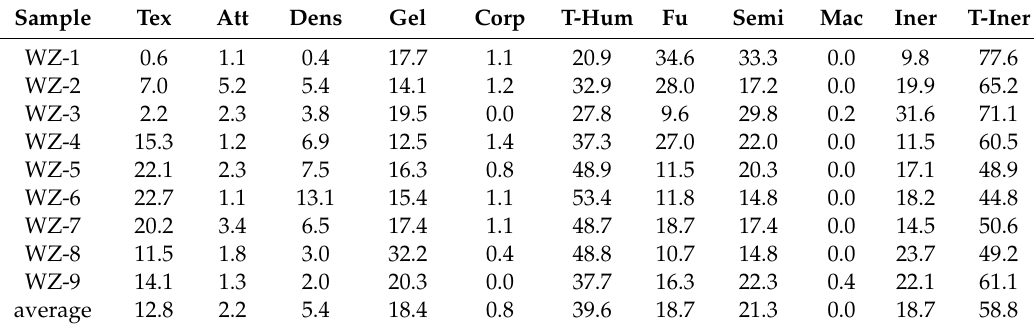
Table 2. Maceral composition of the coal samples (vol